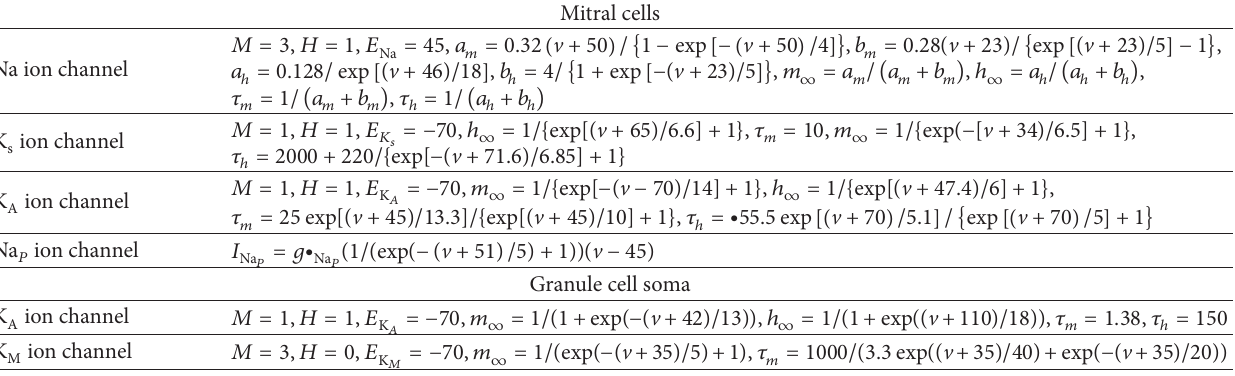
Figure 1: (a) 𝑚 ∞ and ℎ ∞ curves for Na channel of GC; (b) 𝜏 curves for Na channel of GC; (c) 𝑚 ∞ and ℎ ∞ curves for K and K fast channels; (d) 𝜏 values for K channel are scaled up by a factor of 4 from the graph. 𝜏 curves for K and K fast channels. The Table 1: Some parameters in the dynamical model.